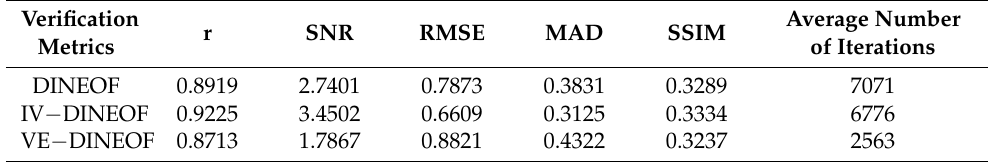
Table 1. Comparison of mean values of verification metrics among DINEOF, IV − DINEOF, and VE − DINEOF for